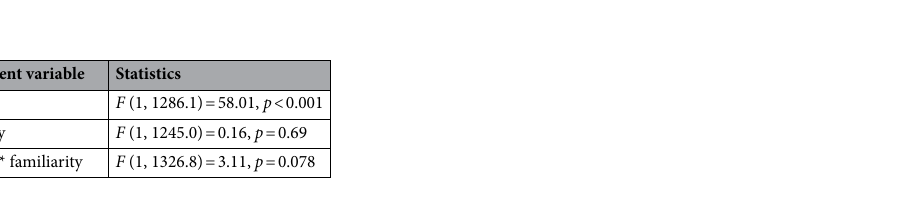
Table 5. Results of the additional GLMM for the Blended